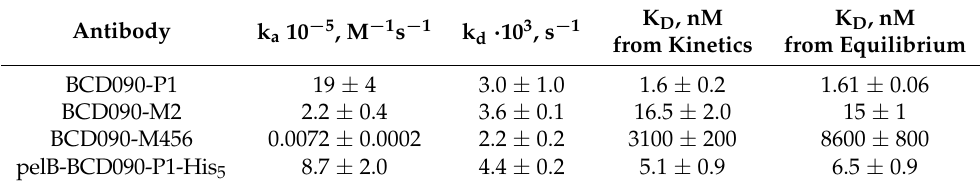
Figure 4. Binding of the single-domain antibodies to the ErbB3 extracellular domain analyzed by surface plasmon resonance. ( a – c ) Experimental binding sensograms after reference subtraction; ( d – f ) equilibrium binding response plotted versus concentration on semi-logarithmic scale, experimental points shown as dots and fits with the Hill equation shown as lines. Data for BCD090-M2 were previously reported in our paper [43]. Table 1. Equilibrium dissociation constants and kinetic rate constants obtained by the analysis of surface plasmon resonance data.